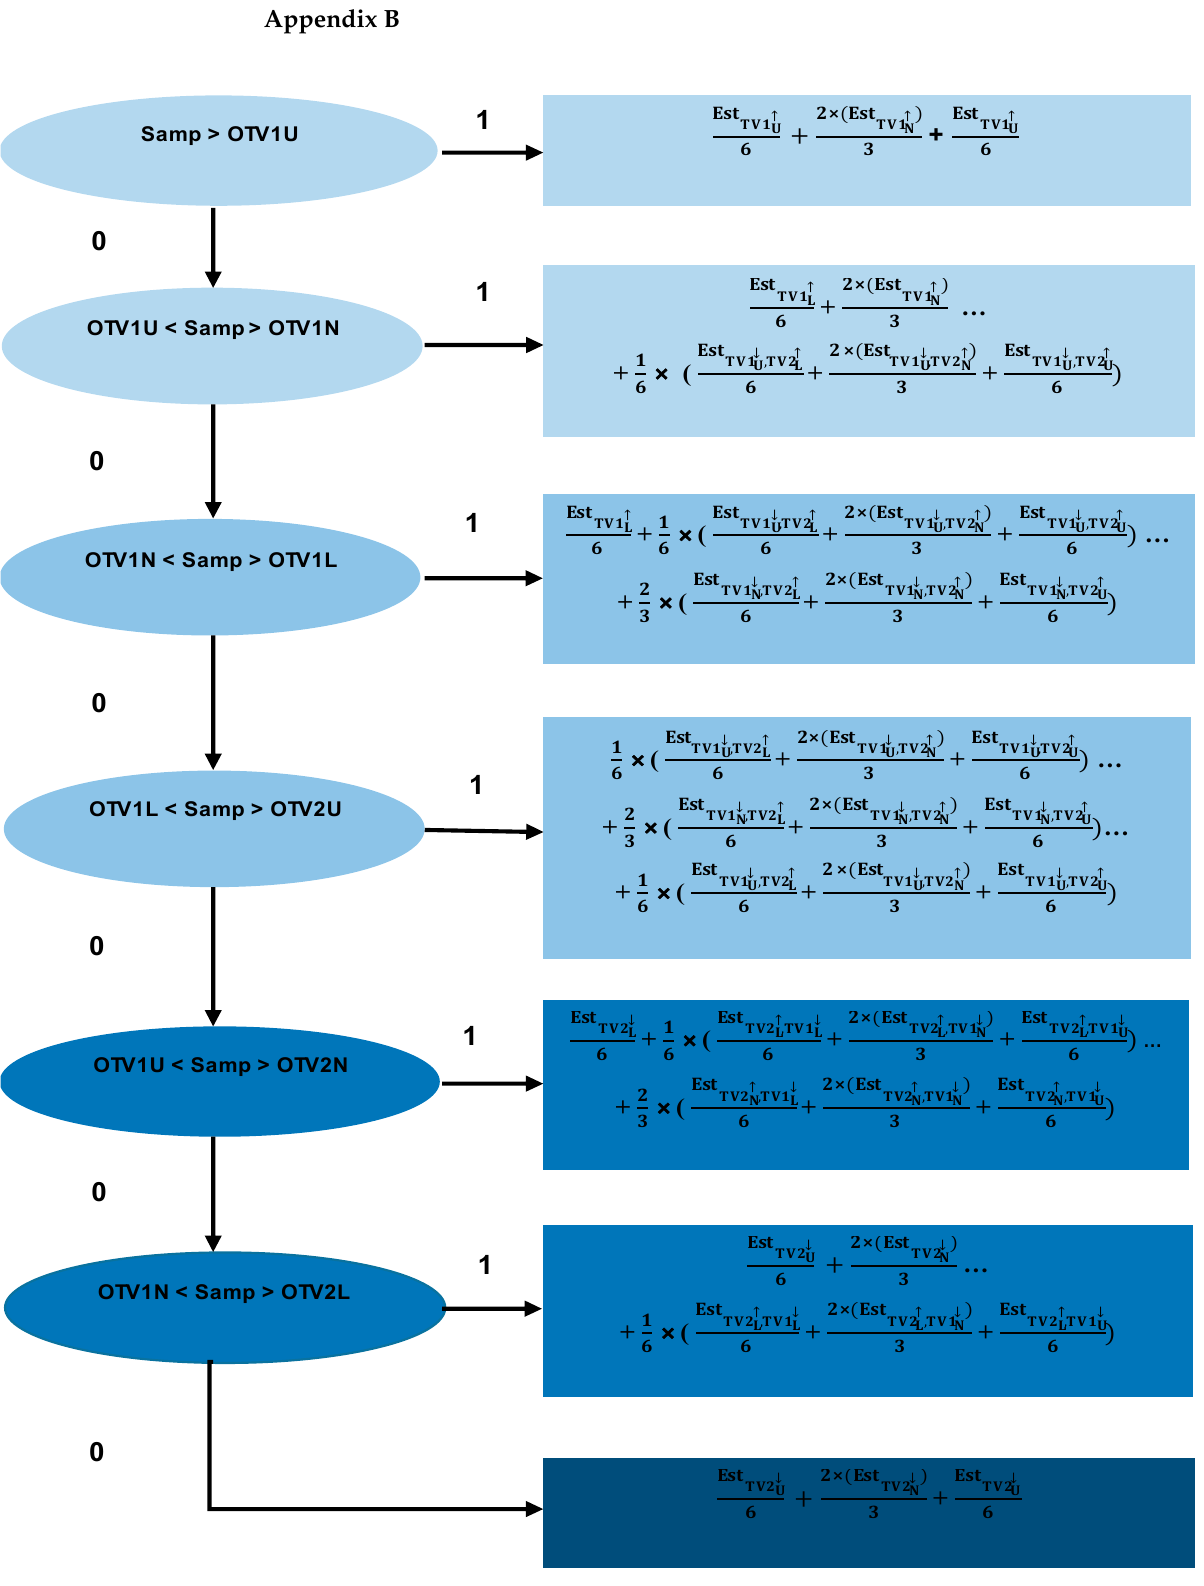
Figure A2. Flow chart of the developed algorithm for density estimation (Samp is the number of samples; OTV1 and OTV2 refer to the optimal thresholds of V1 and V2 and Est are the specific estimators as described in Table 3).